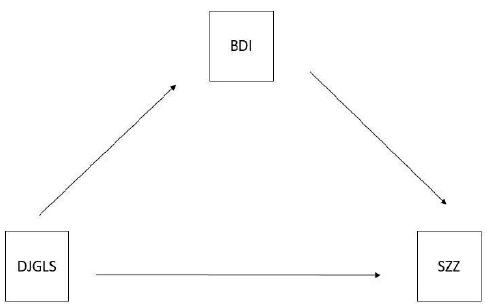
Figure 1. Mediation model 1. DJGLS ‐ De Jong Gierveld Loneliness Scale, SZZ ‐ Scale of Shopping Be ‐ haviour, BDI ‐ Beck Depression Inventory–BDI I ‐ II. Behaviour, BDI-Beck Depression Inventory–BDI